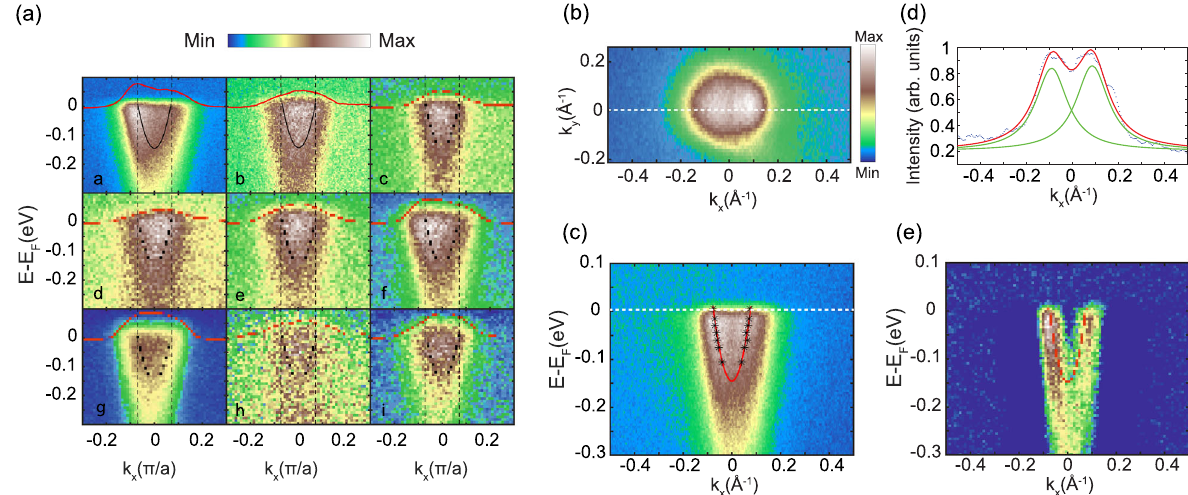
Fig. 3 Photoemission spectrum near the Fermi energy. a Spectra acquired with different photon energies corresponding to different perpendicular momentum k z values, as indicated by black stars in Fig. 2b. For all the acquired bands, the bandwidth and Fermi momentum is similar, as shown by the momentum distribution curves (MDCs) at Fermi energy E F (red) and the matched band (black). The vertical dashed lines indicate Fermi momentum k F . b Intensity map at the Fermi energy assembled from several cuts at different k y values. c Spectrum image obtained along a cut parallel to the Γ -X direction, as indicated by the dashed white line in ( b ). The spectra in ( b ) and ( c ) were measured with an incoming photon energy of 28 eV, providing a higher resolution than in previously shown spectra. d Momentum distribution curve (MDC) extracted from panel ( c ) at Fermi energy E F , and fi tted to two Lorentzian pro fi les to determine the position of Fermi momentum k F . e Second derivative along the energy axis for the spectrum image in ( c ), providing an enhanced view of the dispersing